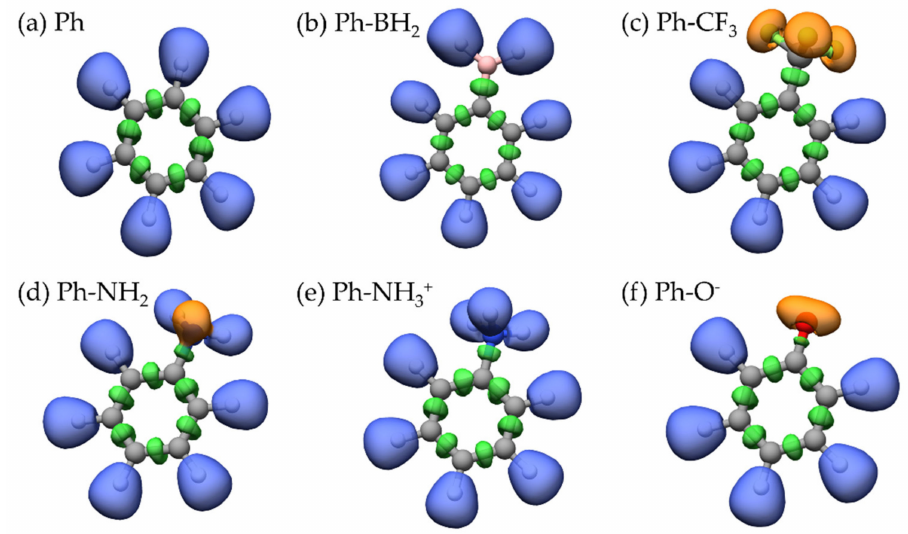
Figure 1. ELF localization domains ( η = 0.8) for six ( a – f ) Ph–X compounds that cover several I/M electronic effects scenarios. Notice that the aromatic ring is structurally stable with respect to changes in the X substituent. In this work, we focus on the V(C i ,C i ± 1 ) disynaptic valence domains, shown in